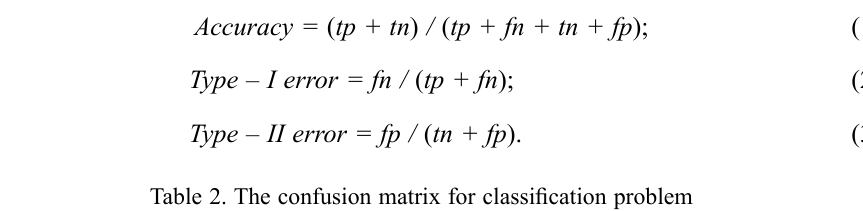
Table 2. The confusion matrix for classification problem Predicted observations Predicted positive Predicted negative Actual observations Actual positive tp fp Actual negative fn